Question: In one sentence, what is this figure communicating?
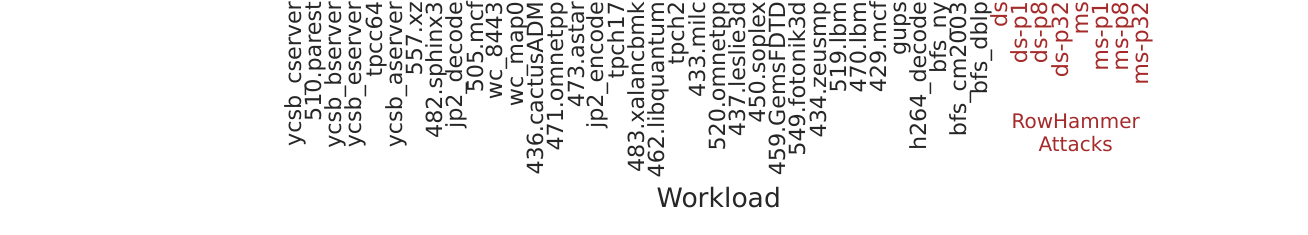
Answer: The distribution of the number of activations a sibling row receives before any sibling row gets activated NRH times for three different NRH values for each benign workload and RowHammer attack (x-axis).